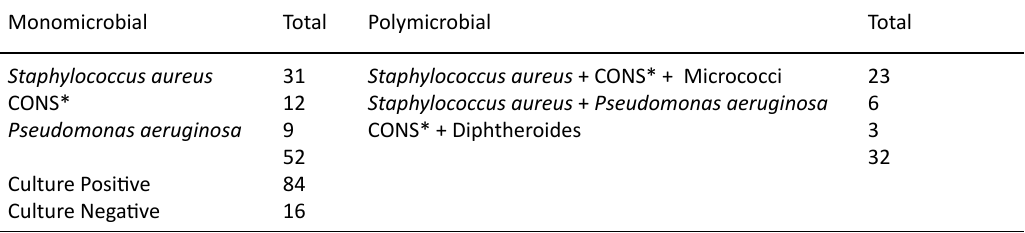
table 2. Isolates from the culture positive samples of the dresses of health care workers Organisms Collar Pocket Side Sleeve Total n=100 n=100 n=100 n=100 N=400 MONOMiCROBiAl Staphylococcus aureus 28 27 26 15 96 CONS* 18 16 12 14 60 Pseudomonas aeruginosa 10 9 13 9 41 Klebsiella sp. 2 4 3 3 12 Total 58 56 54 41 209 POlYMiCROBiAl Staphylococcus aureus + 8 8 8 16 40 CONS* + Micrococci Staphylococcus aureus + 6 7 4 3 20 Pseudomonas aeruginosa CONS* + diphtheroides 4 2 2 8 16 Total 18 17 14 27 76 Culture Positive 76 73 68 68 285 Culture Negative 24 27 32 32 115 *CONS - Coagulase-Negative Staphylococci The overall prevalence of microbial contamination in the dresses of health care workers was 71% (285 culture positive samples). Collar and pocket were found to be the most contaminated areas (26%). Among 285 culture positive samples, single organism (monomicrobial) was found in 209 samples and 76 samples had multiple organisms (polymicrobial). In the monomicrobial samples (n=209), Staphylococcus aureus (46%) was found to be the most common organism isolated. Whereas, in the case of polymicrobial samples (n=76), Staphylococcus aureus , CONS and Micrococci (53%) were the most commonly isolated combination. table 3. Isolates from the stethoscopes of health care workers (n=100) Monomicrobial Total Polymicrobial Total Staphylococcus aureus 31 Staphylococcus aureus + CONS* + Micrococci 23 CONS* 12 Staphylococcus aureus + Pseudomonas aeruginosa 6 Pseudomonas aeruginosa 9 CONS* + Diphtheroides 3 52 32 Culture Positive 84 Culture Negative 16 *CONS - Coagulase-Negative Staphylococci The overall prevalence of microbial contamination found in the stethoscopes of different Health care workers was found to be 84% Among the 84 culture positive samples, 52 were monomicrobial and 32 were polymicrobial in nature. In the monomicrobial samples (n=52), Staphylococcus aureus (60%) was found to be the most important organism isolated. Whereas, Staphylococcus aureus , CONS and Micrococci (72%) were the most common combination of organisms encountered in the polymicrobial samples (n=32). Overall 3% of Staphylococcus aureus were found to be